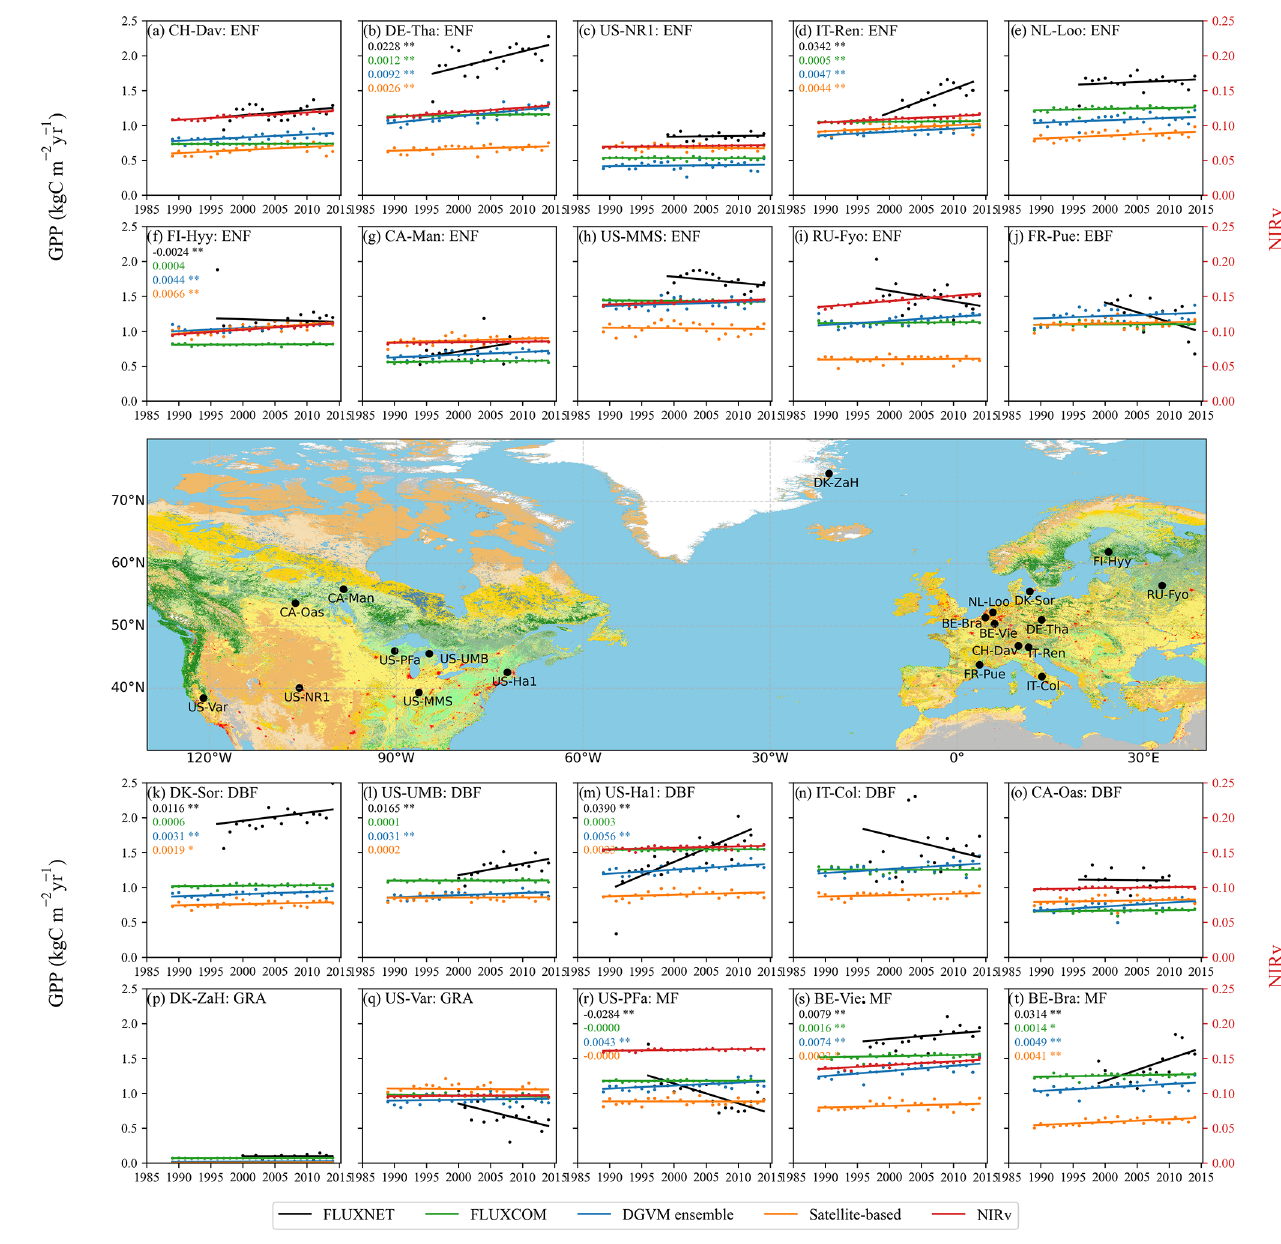
Figure 7. Comparisons of annual GPP over different FLUXNET2015 sites (black), FLUXCOM (green), satellite-based product (orange), DGVM ensemble (blue), and NIRv (red). The global GPP datasets were interpolated into the locations of these 20 sites according to the bilinear interpolation method. Observation sites with significant trends are marked with values. Single ( ∗ ) and double ( ∗∗ ) asterisks indicate that the trend is significant with p < 0 . 1 and p < 0 . 05 following the non-parametric Mann–Kendall trend test. The units of GPP and GPP trend are kgCm − 2 yr − 1 and kgCm − 2 yr − 2 ,